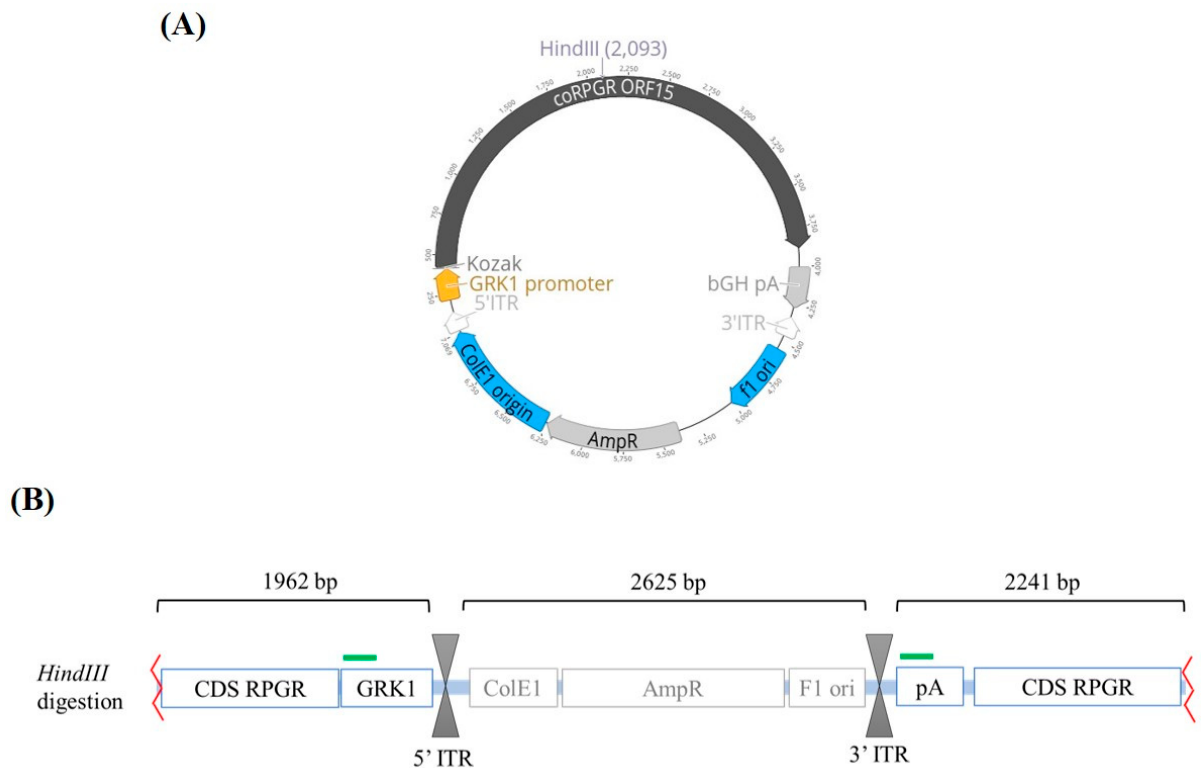
Figure 1. AAV.coRPGR plasmid used in this study. ( A ) Circular map for the AAV.coRPGR expression plasmid used to quantify the AAV8.RPGR titer by Quantitative real-time PCR (qPCR). This plasmid was previously used in a pre-clinical study [20] and contains the rhodopsin kinase promoter (GRK1) that will drive the expression of a codon optimized version of RPGR ORF15 followed by a polyadenylation signal. This transgene cassette is flanked by inverted terminal repeats (ITRs) from AAV2 required for replication and packaging. The restriction enzyme HindIII was used to linearize the plasmid. ( B ) Diagram showing the linearized plasmid following digestion with HindIII restriction enzyme. The green bars indicate the target sequences where the primers and probe bind, i.e., the GRK1 promoter and the bGH polyA (pA) sequence. Abbreviations: CDS; coding sequence, ITR; inverted terminal repeat, AmpR; ampicillin resistance